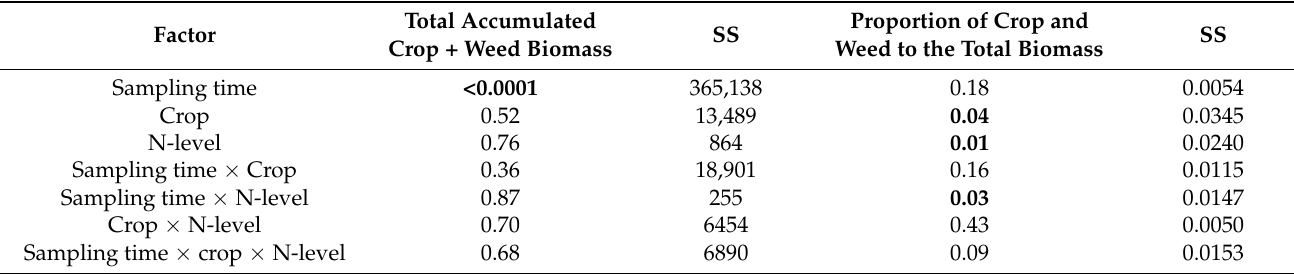
Table 1. p -values following analysis of variance and sums of squares (SS) of total accumulated plot biomass (crops + weeds) measured in g m − 2 and proportional crop and weed biomass to the total biomass in dependency of sampling time, crop and N-level. p -values smaller 0.05 are marked in bold. n = 3.